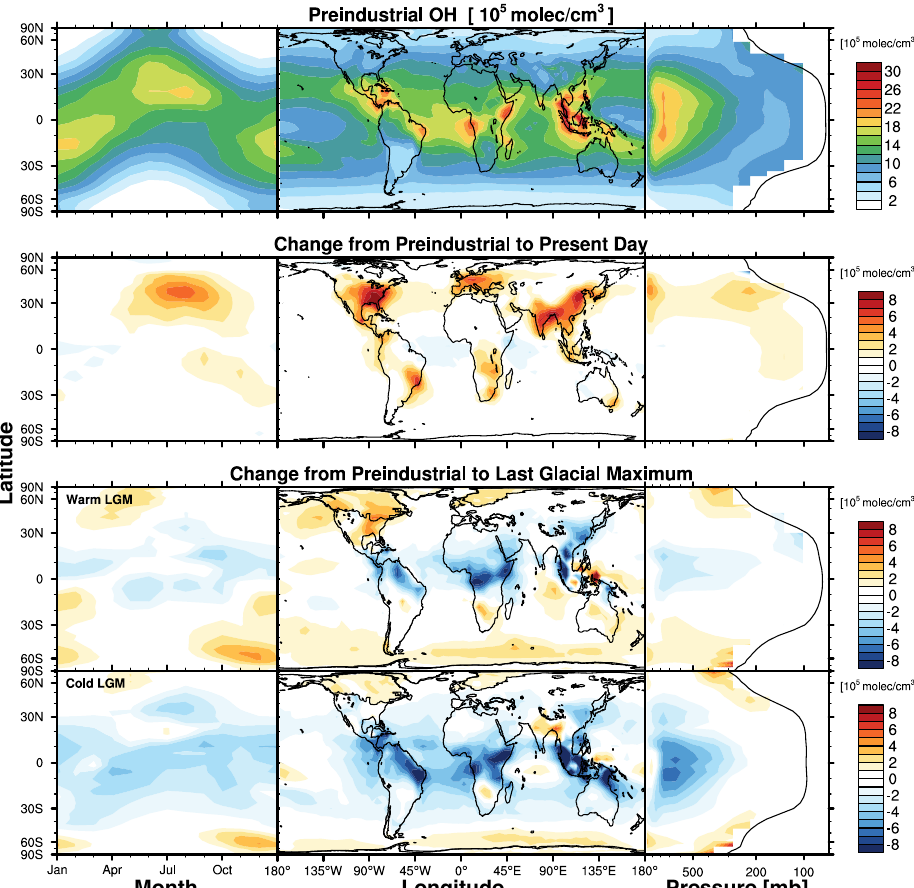
Fig. 12. Spatiotemporal distribution of OH concentrations (10 5 moleccm − 3 ) in the preindustrial simulation (top row), and absolute changes in the present day (second row) and LGM (third and fourth rows) relative to the preindustrial. Each row contains three plots sharing a common ordinate axis (area-weighted latitude) and presents mass-weighted tropospheric OH concentrations averaged across different dimensions. From left to right, a Hovmöller plot shows seasonality in zonal mean column densities, a map shows the horizontal distribution of the tropospheric mean columns, and an altitude plot shows the zonal mean vertical distribution. Mean tropopause pressure is shown as the black line in the rightmost column. All difference plots share a common colorbar.